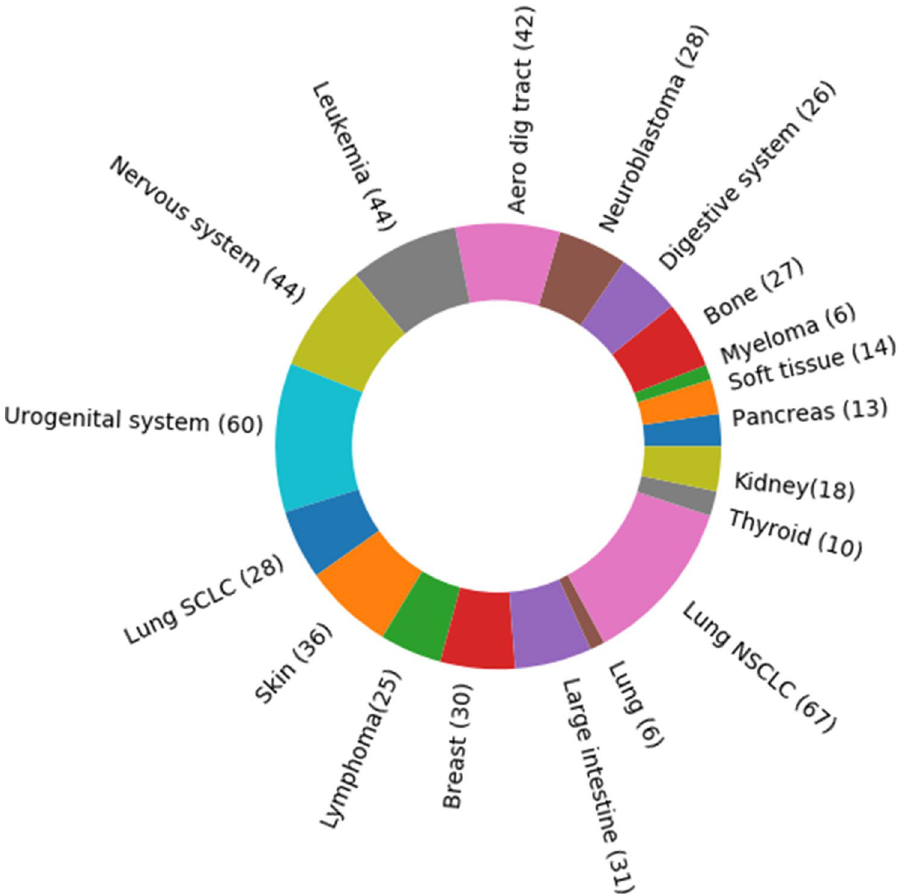
Figure 5. Tissue types in GDSC. The number of cell lines in each tissue type is shown in parenthesis.